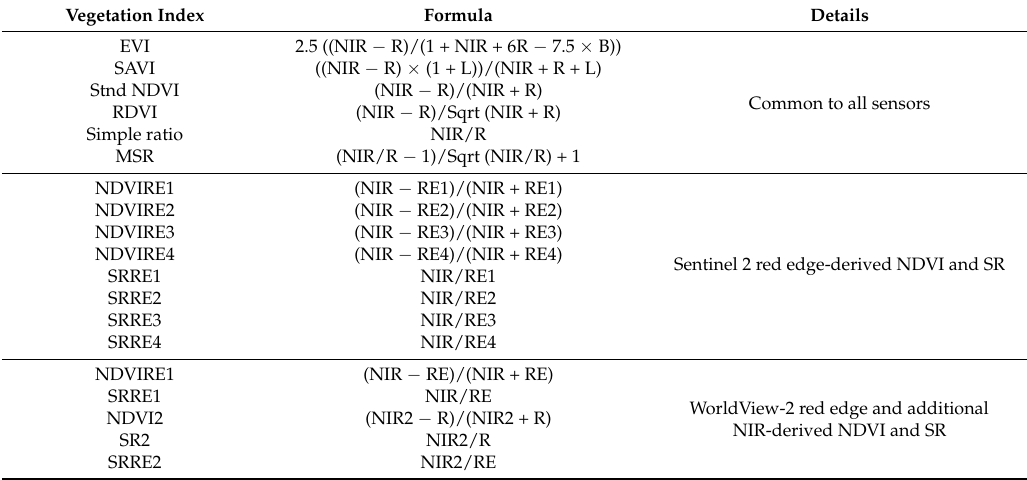
Table 3. Indices used derived from the three sensors’ spectral